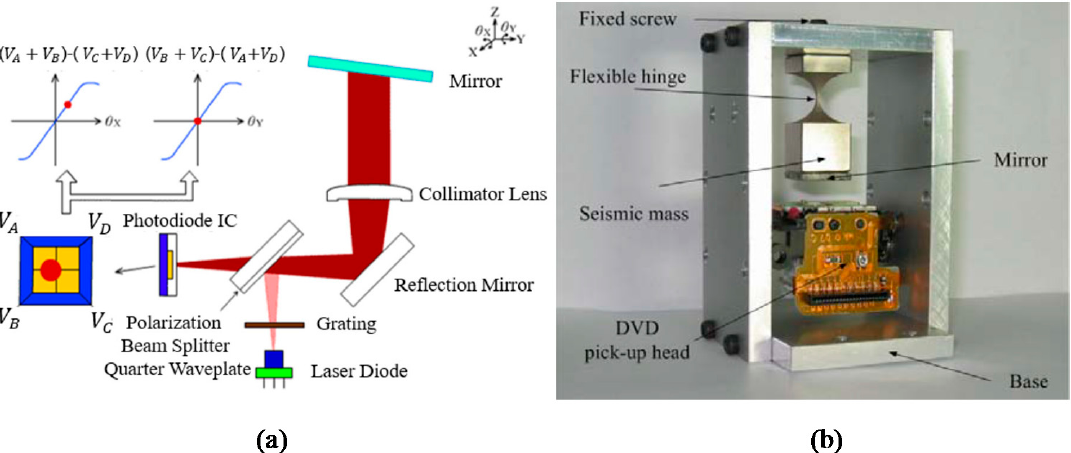
Figure 7. Accelerometer based on the LAC: ( a ) 2D angle sensor and ( b ) 2D accelerometer based on a DVD pickup head. Figure ( a ) is reprinted with permission from Ref. [26]. Copyright 2019 Springer Nature.